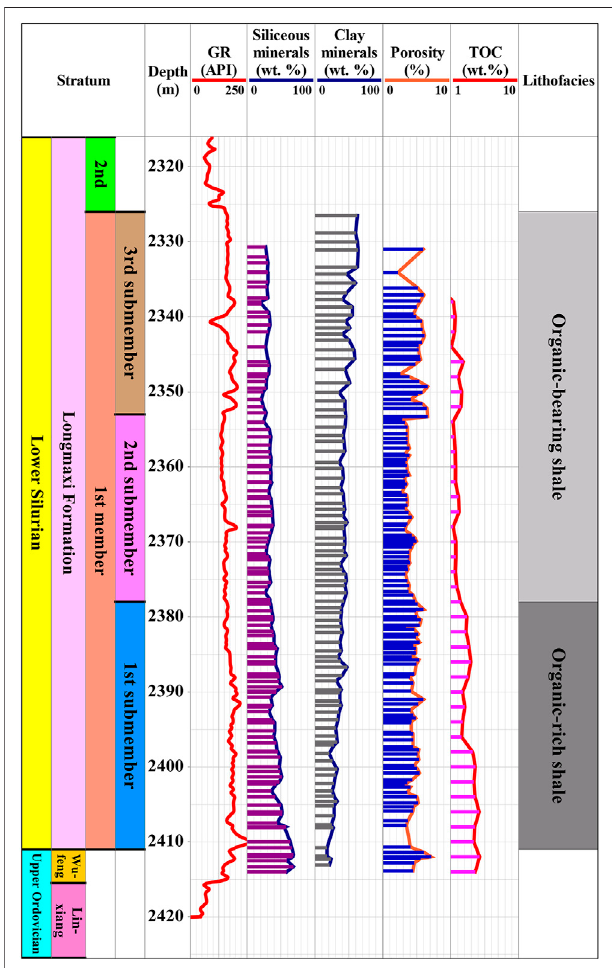
FIGURE 5 | The divided sub-members in JiaoYe 1 Well in Long 1 Fm. and analysis results of mineral composition, TOC content and porosity. See Figure 1 for the well